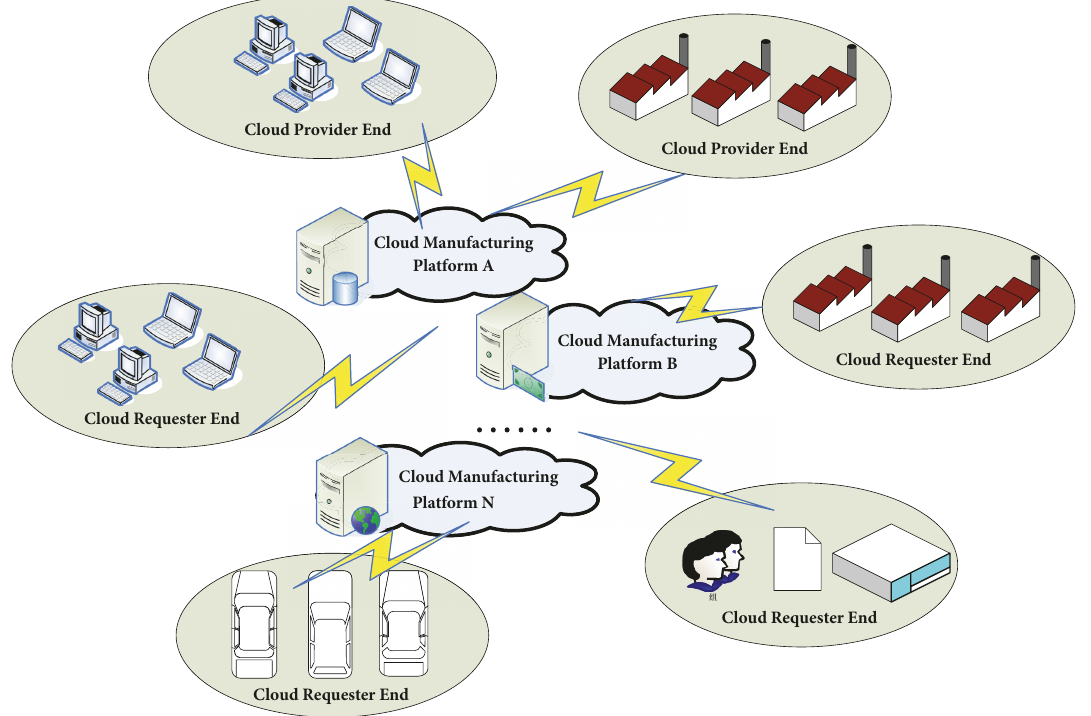
Figure 1: The architecture of CMfg system